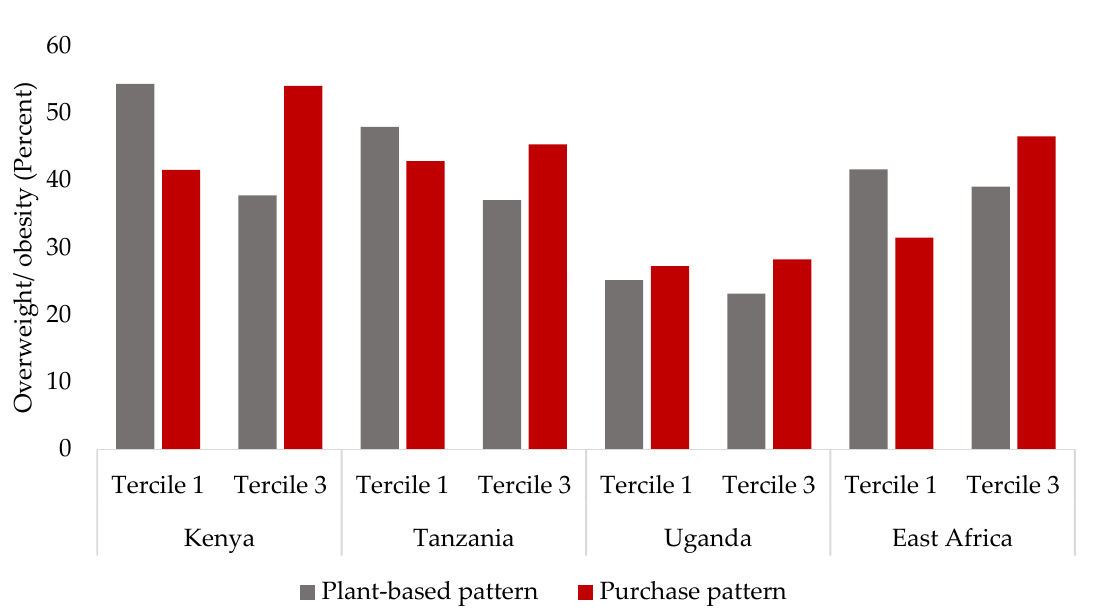
Figure 2. Percentage of overweight and obese rural women in the lowest (tercile 1) and highest (tercile 3) segments of the patterns (only plant-based and purchase patterns are shown here) in Kenya (N = 210), Tanzania (N = 123), Uganda (N = 110), and East Africa (N = 443). For Uganda, figures of plant-based pattern II are shown, while purchase pattern II is shown for Kenya.